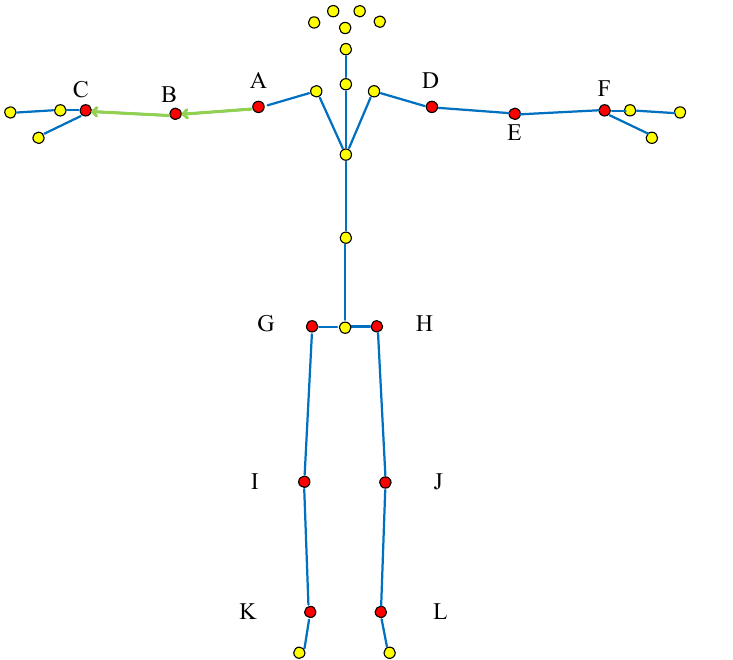
Figure 5. Local “joint method” vector selection (The red dots are the selected bone joint, and yellow dots are bone joint points that do not need to be selected. Green lines are selected joints, blue lines are not selected joints. The letters correspond to Table 1 and Figure 1).